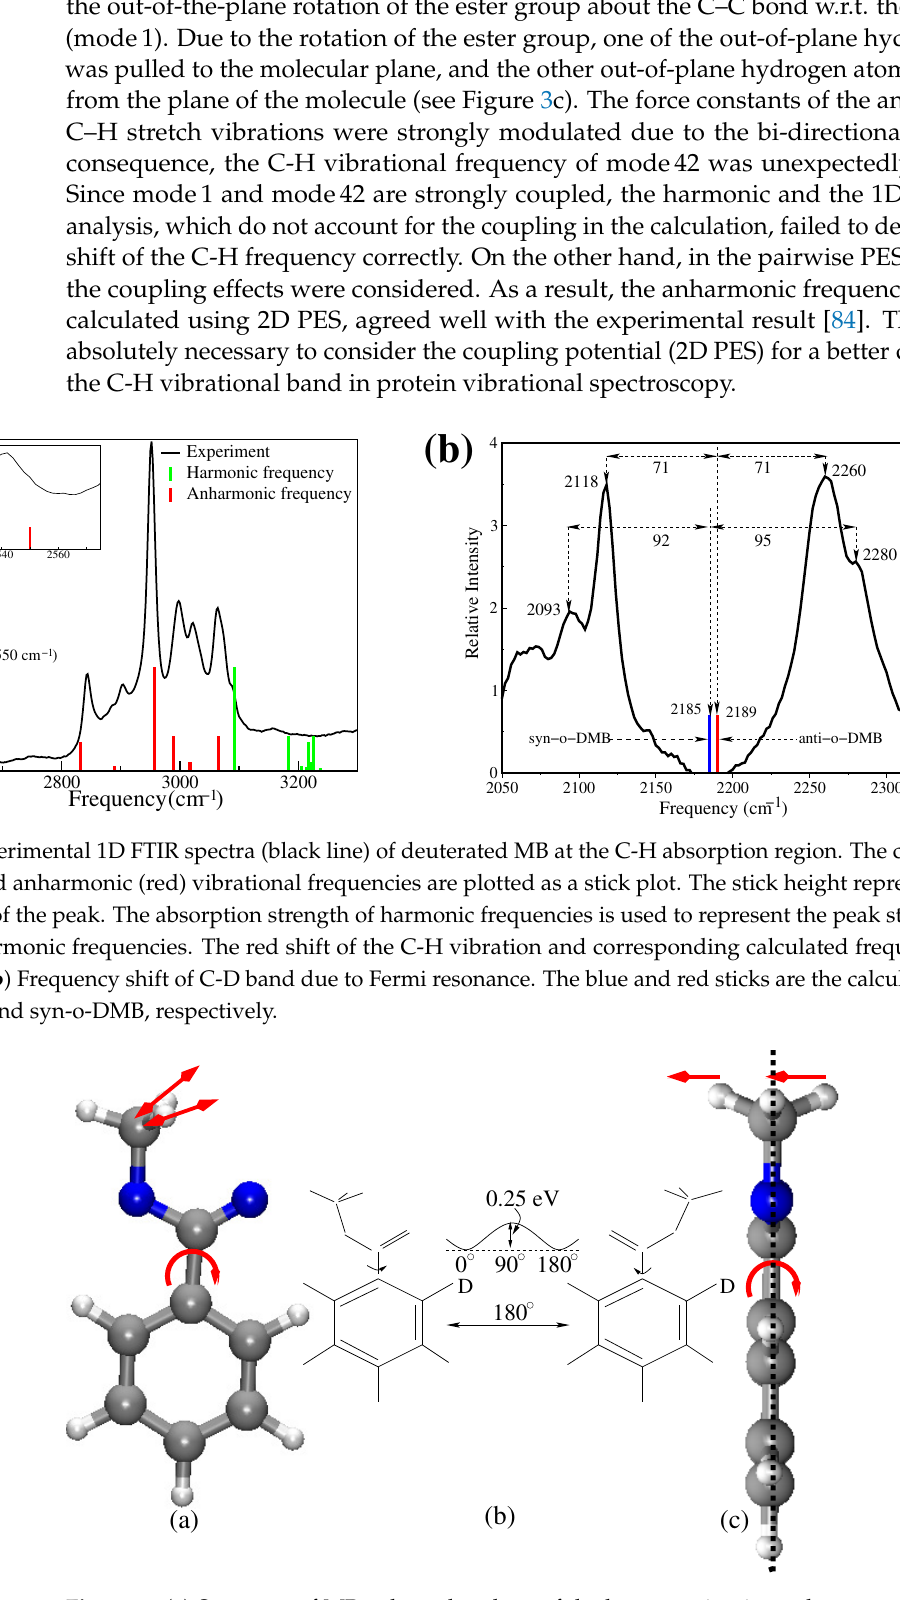
Figure 3. ( a ) Structure of MB, where the plane of the benzene ring is on the paper, ( b ) two stable conformers of MB and the calculated barrier height for their interconversion, and ( c ) the structure of MB, where the plane of the benzene ring is orthogonal to the plane of paper